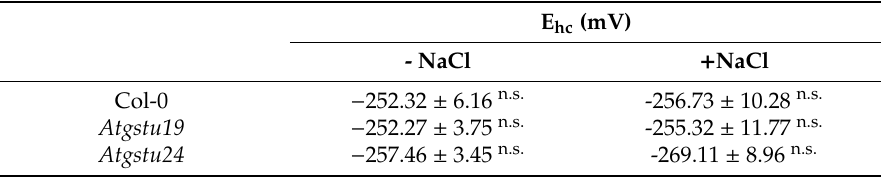
Arabidopsis plants treated with 150 mM NaCl for 48